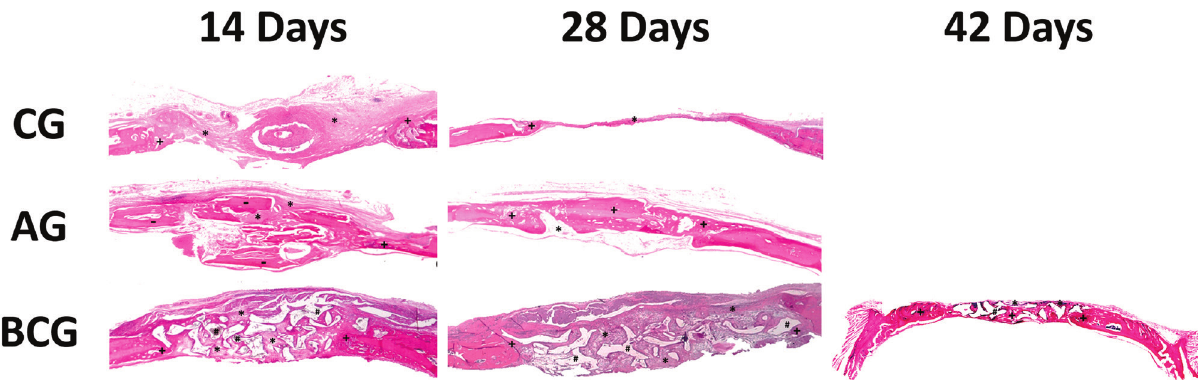
Figure 1- Histological images of experimental groups (CG at 14 days and CG at 28 days; AG at 14 days and AG at 28 days; BCG at 14 days, 28 days, 42 days. (1.6x magnification – Loupe). Different signs were used to identify the type of tissue: *=Connective tissue; += Neoformed bone; #=BoneCeramic particles; -=Autograft particles